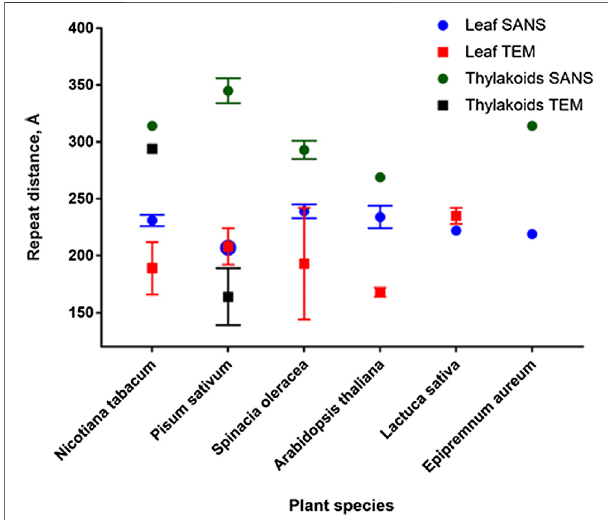
FIGURE 6 | Comparison of repeat distances obtained by SANS and TEM for isolated thylakoids and plant leaves.